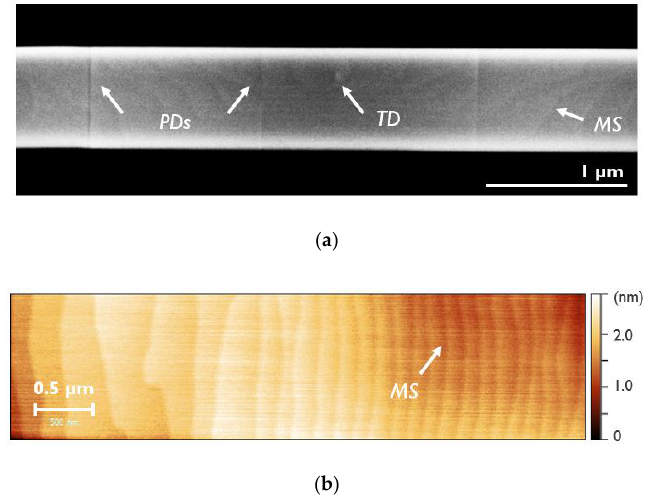
Figure 6. ( a ) is a representative ECC image of a GaSb NR deposited on top of a 100 nm wide trench. ( b ) is an atomic force microscope (AFM) image of a comparable GaSb NR surface. The white arrow points to only one mono-atomic surface step (MS), but each contrast line is a MSs.